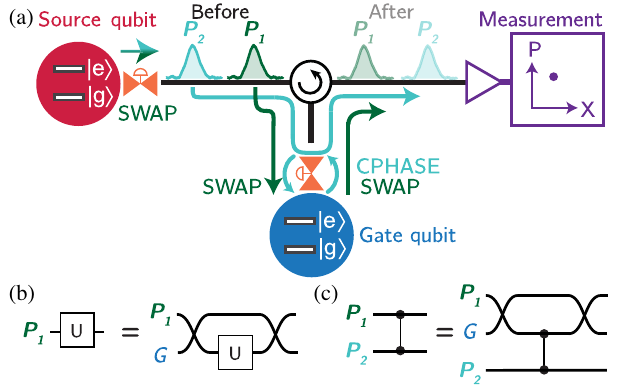
FIG. 1. (a) Schematic representation of the concept of the experiment. We generate photonic qubits P 1 (dark green) and P 2 (turquoise) from the source qubit (red) via swap gates ( SWAP ) mediated by a tunable coupling depicted as a control valve (orange). The photonic qubits propagate through a circulator to the gate qubit (blue), performing a swap gate ( SWAP ) or a controlled-phase gate ( CPHASE ). We linearly amplify the output field and measure the photonic qubits using heterodyne detection (purple). (b),(c) Equivalent quantum circuits implemented to realize (b) an arbitrary single-qubit gate U and (c) a photon- photon controlled-phase ( CPHASE )